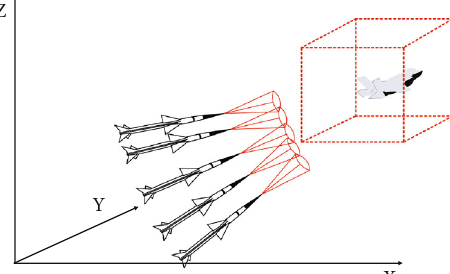
Figure 1: Schematic diagram of multimissile coordinated